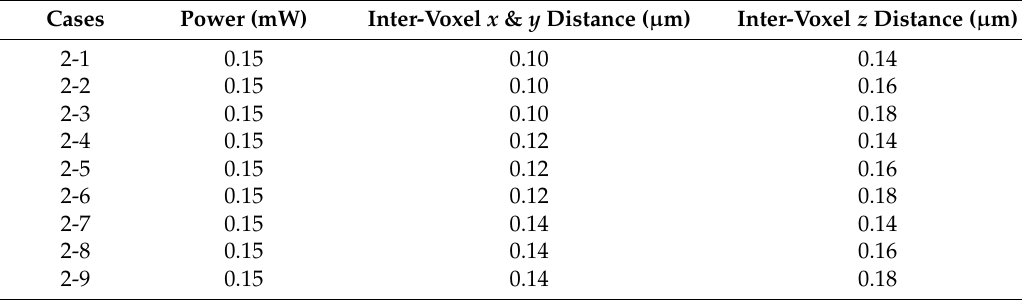
Table 2. Fabrication parameter combinations with different inter-voxel